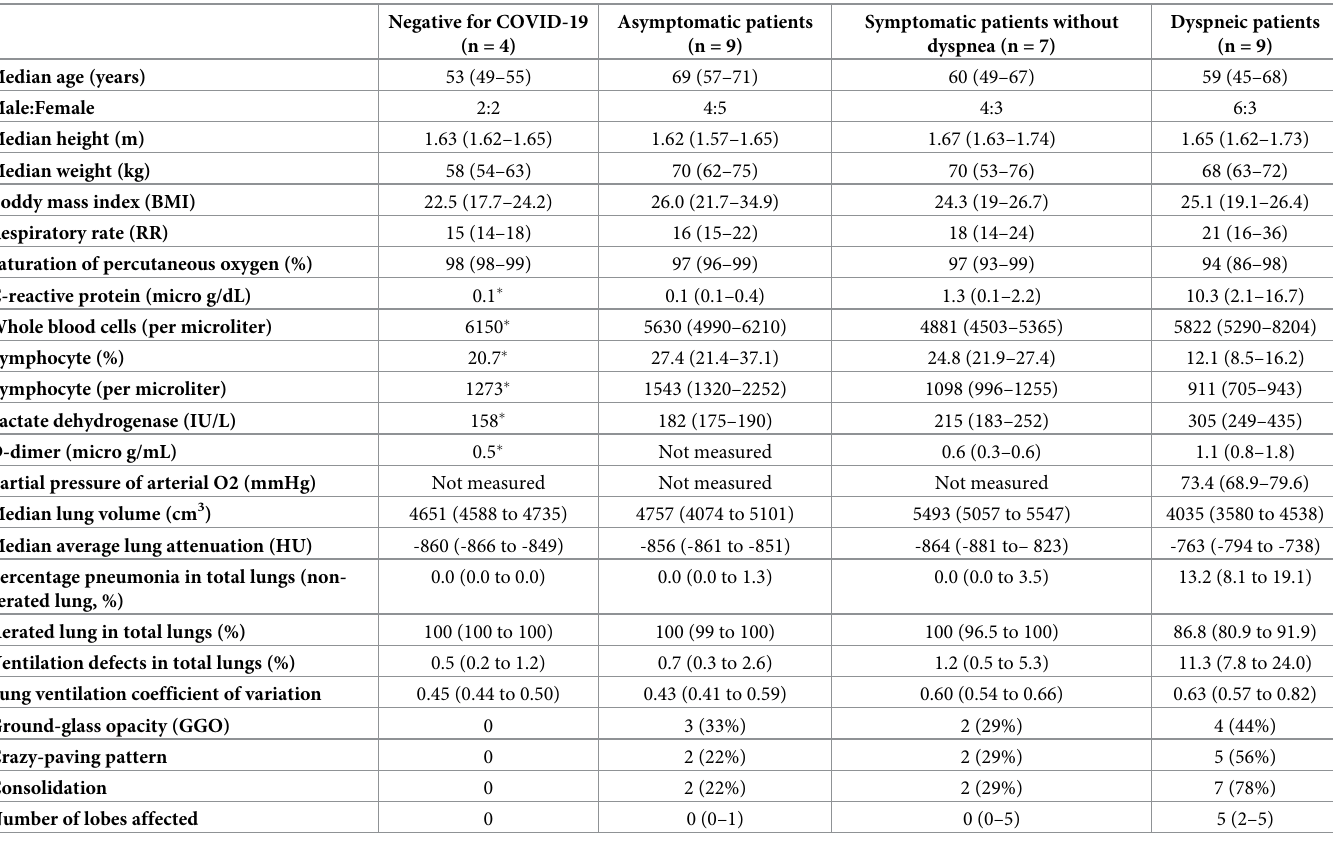
Table 1. Patient characteristics, anatomical, and functional CT